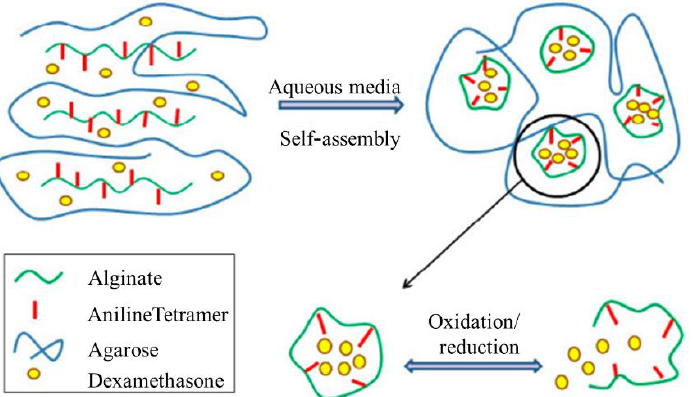
Figure 30. Schematic of drug release: ADA-AT chains self-assemble into vesicles in an aqueous medium, and dexamethasone molecules are entrapped in them. By applying electrical potential, vesicles are disrupted during oxidation/reduction procedures, leading to drug release. Reprinted with permission from Atoufi, Z.; Zarrintaj, P.; Motlagh, G.H.; Amiri, A.; Bagher, Z.; Kamrava, S.K.